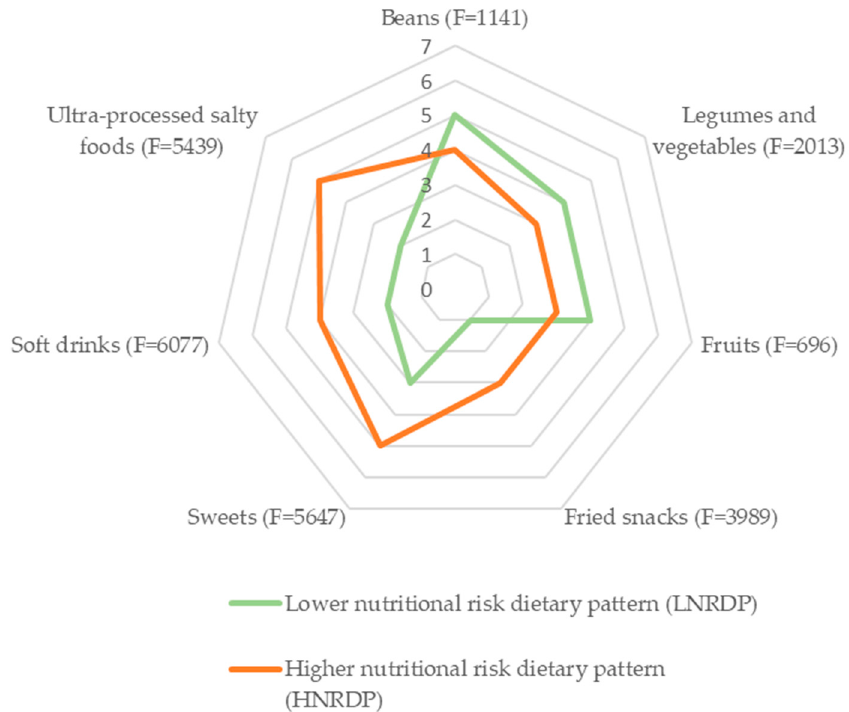
Figure 1. Average weekly food intake frequency according to the Brazilian school adolescents’ dietary pattern and F. statistic, according to cluster analysis. National School Health Survey (PeNSE), 2015. Note: Cluster I (lower nutritional risk dietary pattern) = 10,257 individuals (61.6%; 95%CI: 60.6–62.6) and Cluster II (higher nutritional risk dietary pattern) = 6153 individuals (38.4%; 95%CI: 37.4–39.4). p value < 0.001 for the Analysis of Variance (ANOVA) of the cluster analysis.